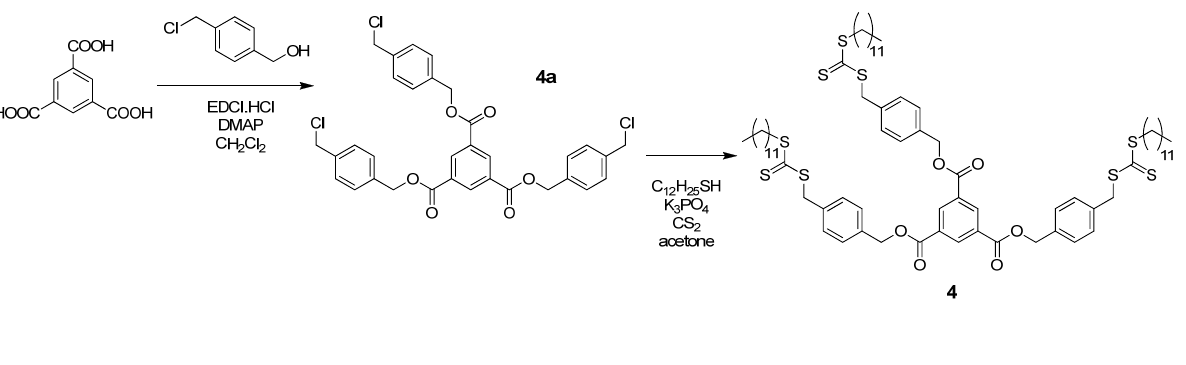
Figure 2. 1 H NMR spectrum of 4 in CDCl